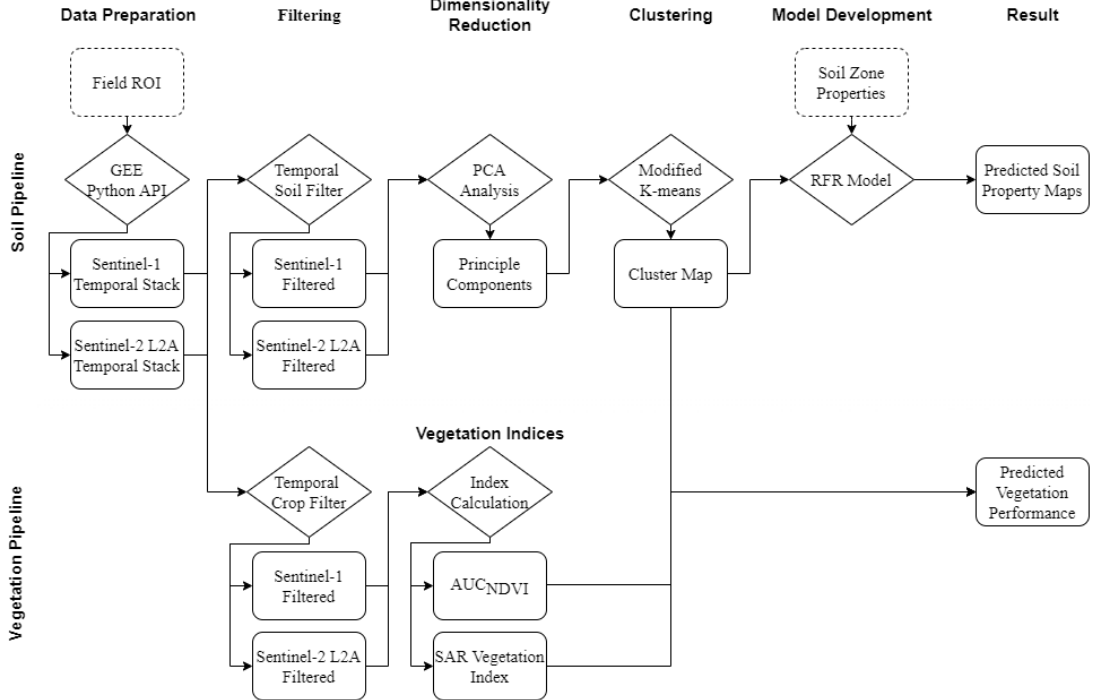
Figure 2. The developed process chain for the suggested field-scale soil zoning and property prediction approach. The rounded rectangles represent data as ROI, image or image stack, and the diamond shapes are for applied filters or algorithms, broken lines represent data input needed from the user, and solid lines represent products calculated during the